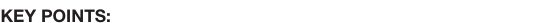
CI for the proportion of response estimate was found to be